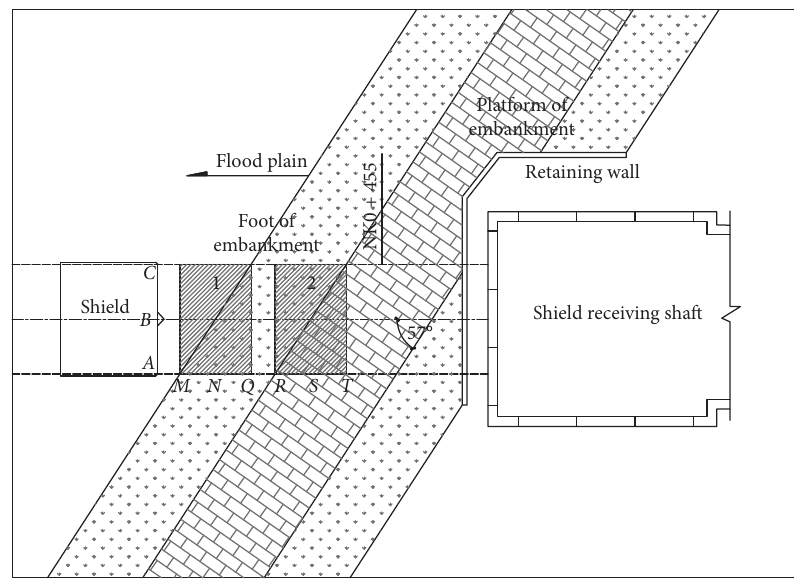
Figure 5: Sketch of the tunnel passing under the embankment.